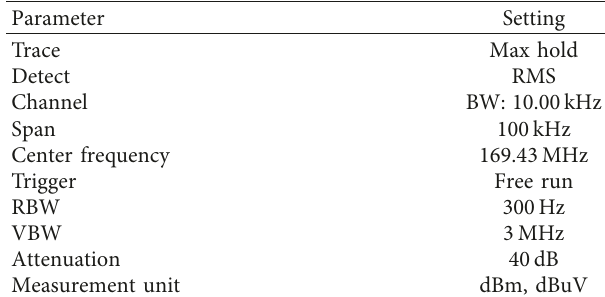
Table 2: Spectrum analyzer